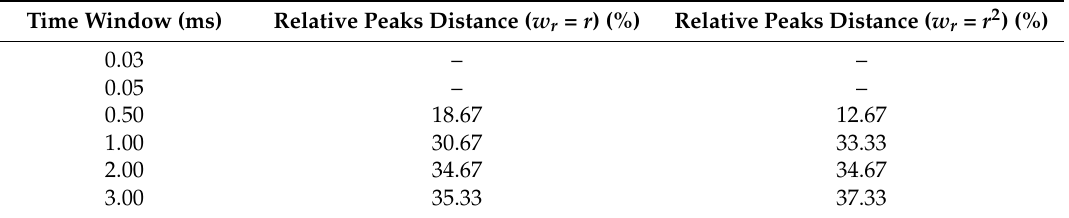
Table 2. Calculated values of relative peaks distance of bimodal distribution for specimen #5.